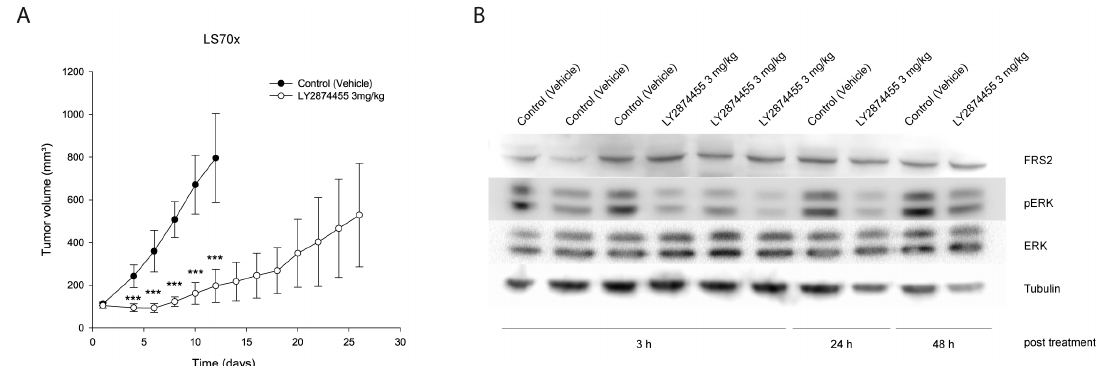
Figure 5. Growth inhibitory effect of LY2874455 in vivo on LS70x, a FRS2 -amplified xenograft. ( A ) in vivo study with FRS2 -amplified tumors of LS70x xenografts ( n = 6) treated twice per day (BID) with LY2874455 3 mg/kg or control vehicle for up to 28 days until tumor size reaches a limit of 1 cm 3 . Data shown as means ± SEM *** p ≤ 0.001; unpaired two-tailed t -test treated versus vehicle treated; ( B ) Western blots showing the level of phosphorylated and total ERK in lysates extracted from LS70x tumors treated in vivo with vehicle or LY2874455 until endpoint. The tumors were harvested at the indicated time after last treatment. α -tubulin is used as loading